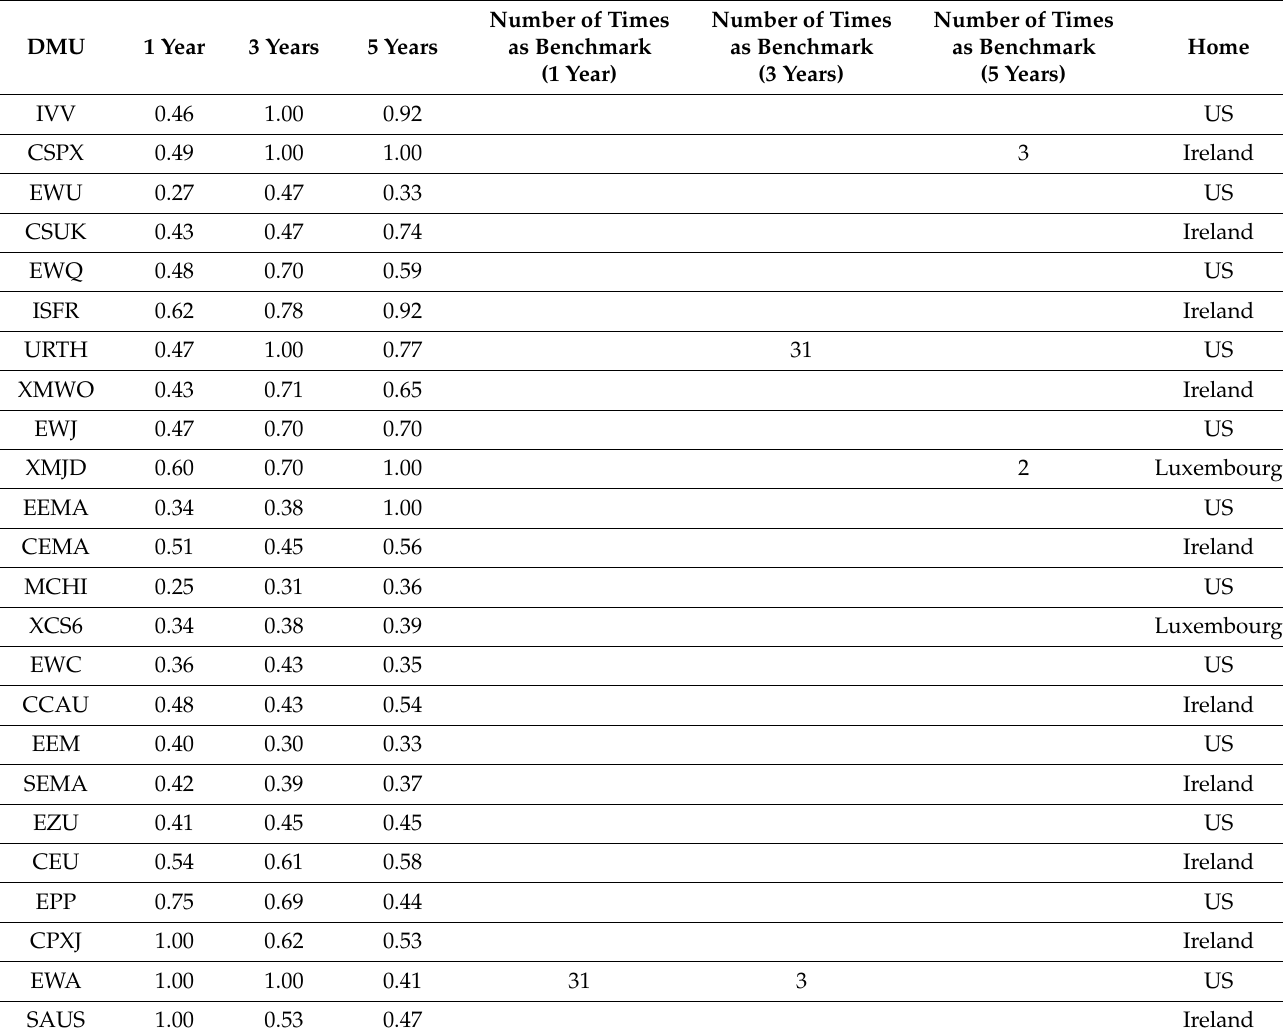
Table A11. Efficiency levels and benchmarks computed with model